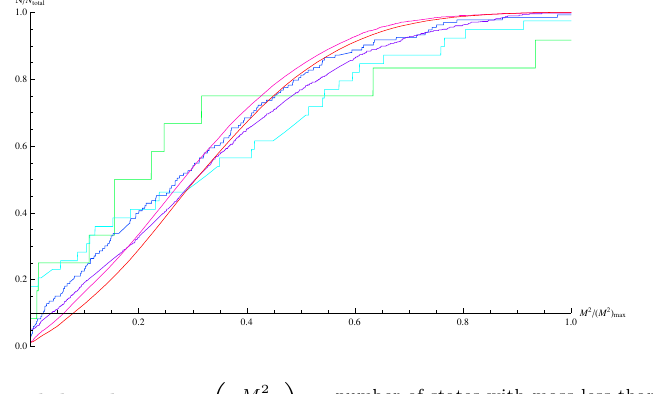
Figure 15 . Normalized distribution F N 3 , g = m , and the harmonic resolution K = 3 ; 4 ; 5 ; : : : ; 8. A similar distribution was obtained in [29].